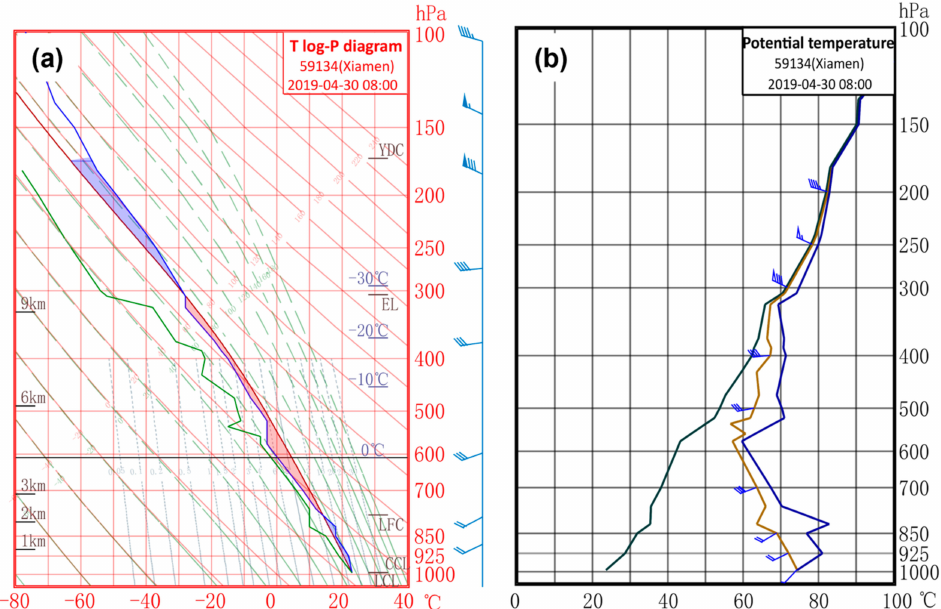
Figure 3. ( a ) Skew T-log P diagram of the sounding at 08:00 local standard time (LST) on 30 April 2019 with temperature (in blue), dew point temperature (in green), and stratification (in red) curves. Wind bards (long feather: 4 m s − 1 ) are plotted on the right. Heights are given along the stan- dard pressure levels (meters above ground level, or m AGL). The 0 ◦ C level was at ~4.3 km AGL. ( b ) Potential temperature (in black), θ se (in brown), and saturated θ se (in